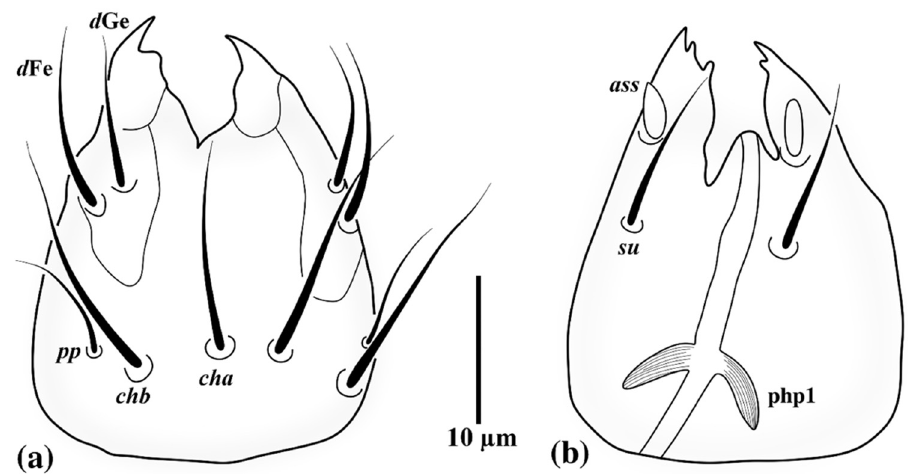
Figure 1. Allopygmephorus coelostomus sp. nov. ( a ) dorsal view of gnathosoma; ( b ) ventral view of gnathosoma. Type